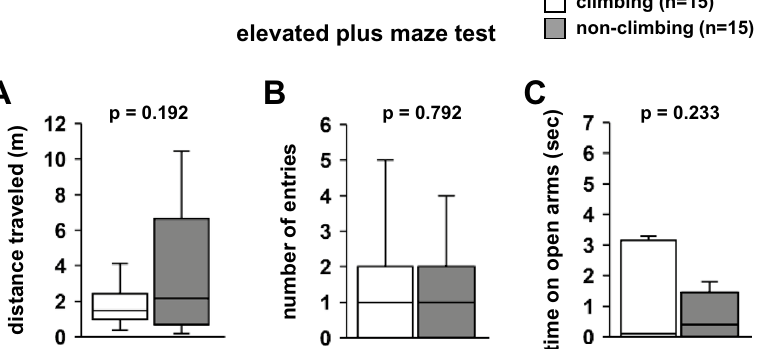
Figure 5. The effect of grid-climbing prevention on performance in the elevated plus-maze test. Elevated plus-maze test: the total distance travelled ( A ), number of entries into open arms ( B ), and time spent in open arms ( C ). Data are presented as box plots. Statistical significance is represented by asterisks: * p < 0.05, + p < 0.1. P -values were calculated using the one-way analysis of variance ( A - C ). ( A – C ) climbing: n = 15; non-climbing: n =